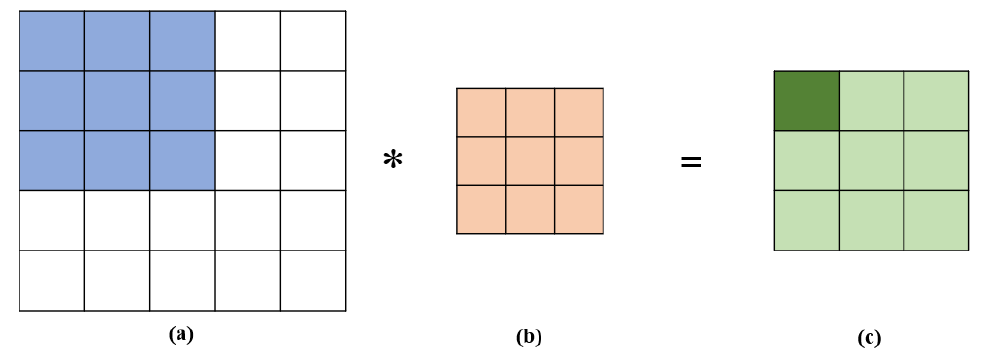
Figure 6. Schematic diagram of convolution operation: ( a ) the input matrix, which is acquired data matrix in this paper; ( b ) convolution kernel matrix; ( c ) the convolutional result matrix. The ∗ represents convolution operation.